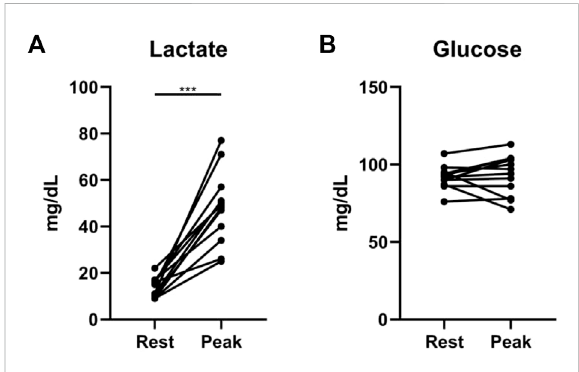
FIGURE 1 Exercise-inducedchangesinlactate (A) andglucose (B) levels from rest to peak exercise, measured from pulmonary artery catheters in 12 patients with systemic